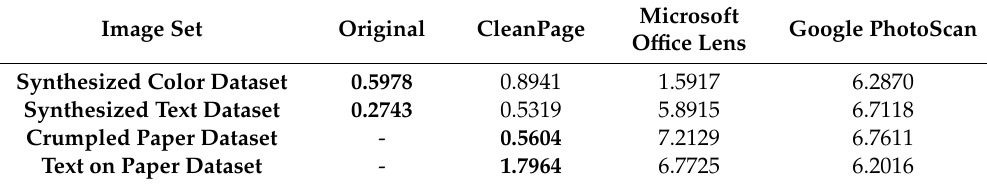
Table 2. Comparison of scanning methods using discrete entropy (DE) as a quality measure. In each case, approximately fifty subjects were scanned using each method to produce the four datasets listed. The results presented are the average score across each dataset. A lower DE score suggests better quality.